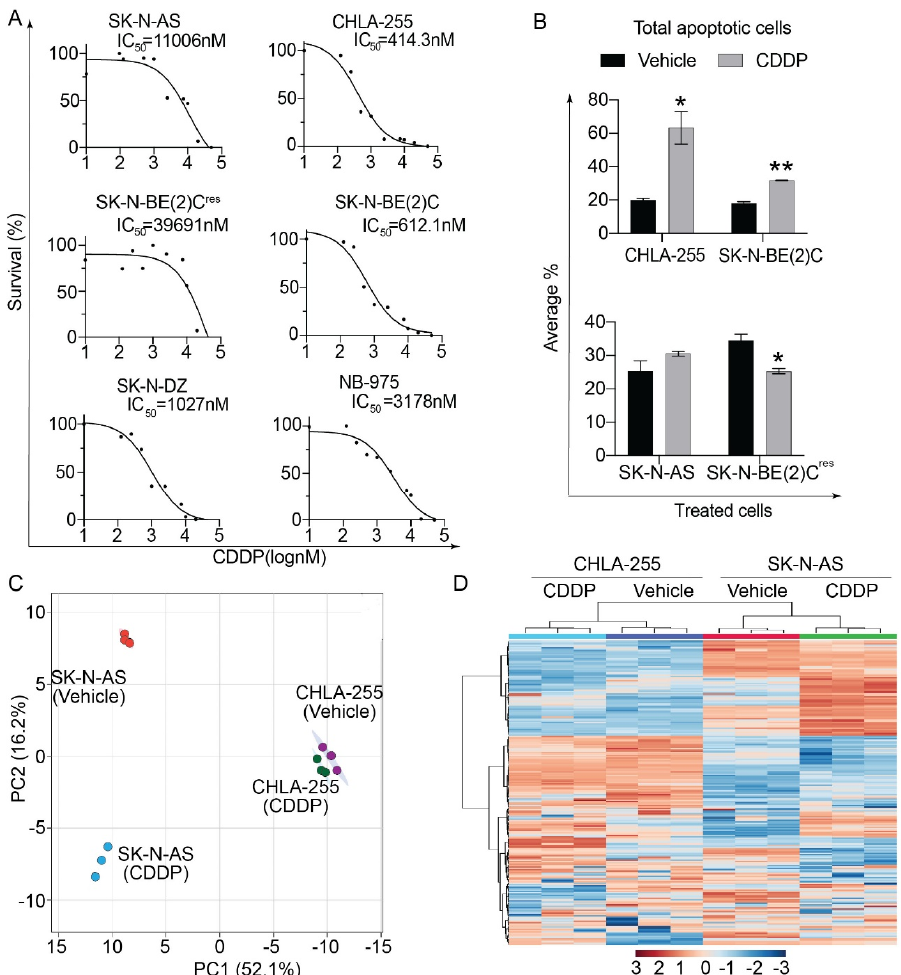
Figure 1. Cisplatin (CDDP) treatment alters metabolism in neuroblastoma . ( A ) The half-maximal inhibitory concentration (IC 50 ) curves showing different survival response in neuroblastoma cells upon cisplatin (CDDP) treatment. Each data point represents mean ± SE values from three biological replicates. ( B ) Bar graphs showing percentage of total (late and early) apoptotic cells after 24 h treatments with either vehicle or CDDP treatments in neuroblastoma cells. * and ** indicate p < 0.05 and p < 0.01 obtained from three biological replicate data derived using Student’s t -test. ( C ) Principal Component Analysis (PCA) plot showing the segregation of vehicle and cisplatin (CDDP) treated cells based on their metabolite profiles. Each colored circle represents a biological replicate of the treatment condition. ( D ) Heatmap showing the clustering of vehicle and cisplatin (CDDP) treated groups. Colored cells in each row represent metabolites, and each column represents a sample. The scale for the heatmap is shown under the heatmap.